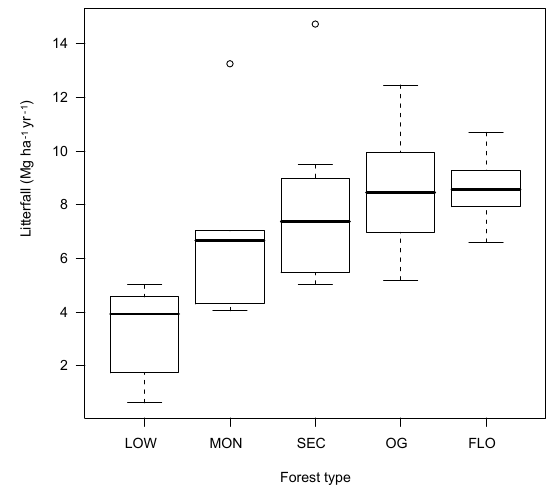
Fig. 2. Total annual litterfall in different forest types. LOW: short- statured tropical forests (see Methods for a description), MON: montane tropical forests, SEC: secondary tropical forests, OG: old- growth tropical forests, FLO: partially flooded tropical forests. For each forest type, the thick horizontal lines represents the mean, the box represents the standard deviations (possibly asymmetrical), and the dotted line represents the 95% confidence intervals. Two out- liers were detected, both above 12Mgha − 1 yr − 1